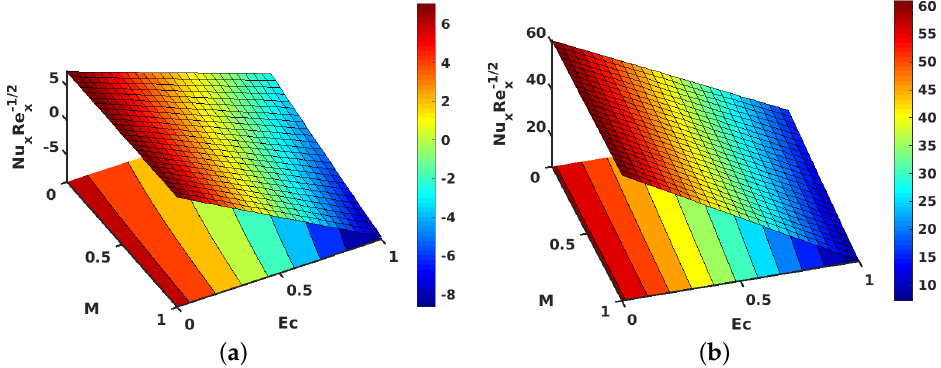
Figure 12. Effect of Eckert number ( Ec ) and magnetic parameter ( M ) on local Nusselt number. ( a ) Injection; ( b ) suction.